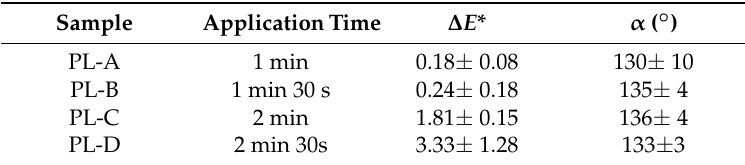
Table 3. The colour variation ( ∆ E *) and the static contact angle measurements ( α ) on the PL samples after the spray coating of 0.02 M TiO 2 NRs n-heptane dispersion, for the different spraying time.